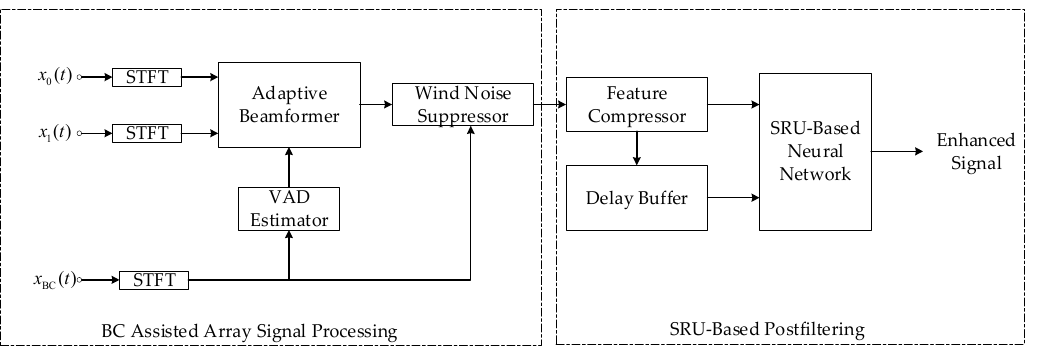
Figure 7. The system pipeline is divided into two parts: BC-assisted array signal processing and SRU-based postfiltering.